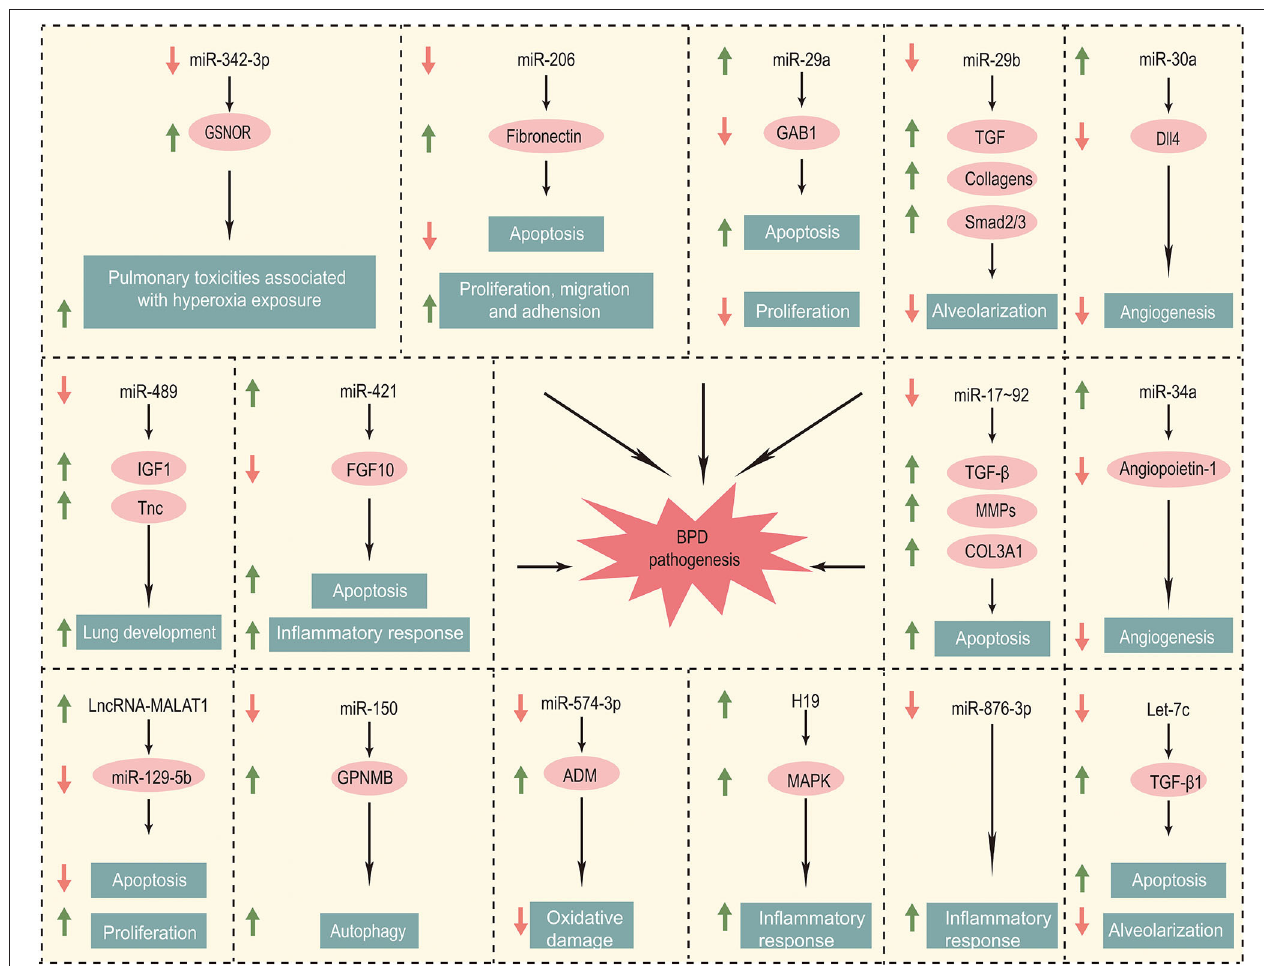
FIGURE 1 | Non-coding RNA involved in the pathogenesis of